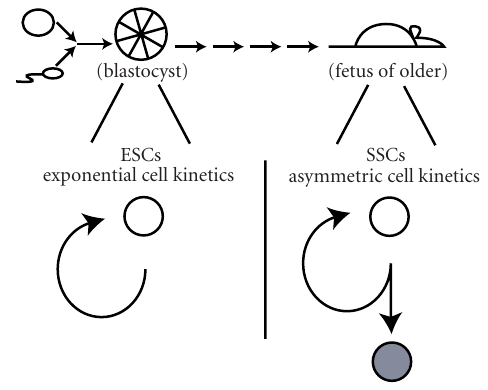
Figure 1: ESCs versus SSCs. Two basic type of stem cells exist, the ESC and the SSC. ESCs are derived from blastocysts and divide with exponential cell kinetics. SSCs, however, are derived from somatic tissues and divide with asymmetric cell kinetics.